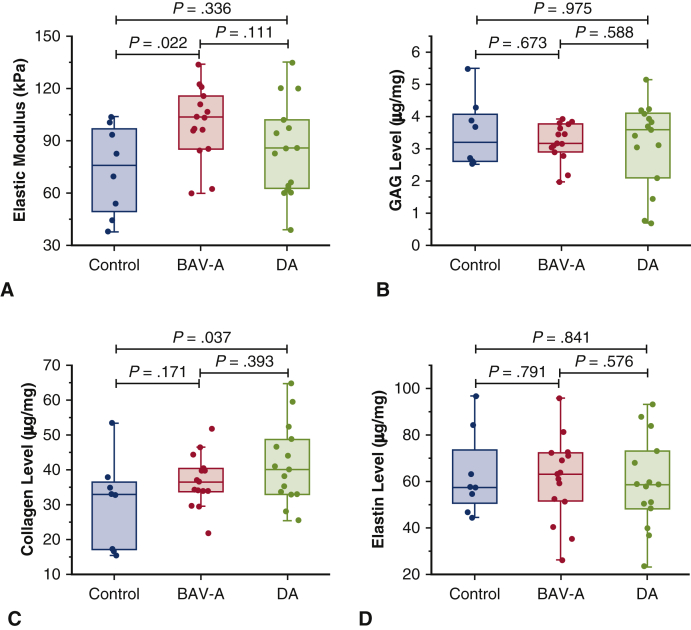
Micromechanical and biochemical data for control (n = 8), BAV-A (n = 15), and tricuspid aortic valve idiopathic DA (n = 15). All data was represented as box plots and data overlaid with upper and lower borders of the box to represent the upper and lower quartiles, and the middle horizontal line to represent the median. The upper and lower whiskers represent 5th and 95th percentile of the data. Variables acquired from the specimens included A, elastic modulus (E) from oscillatory nanoindentation, and levels of B, GAG; C, collagen; and D, elastin from biochemical assays. BAV-A was significantly more elastic in comparison with the control and DA. However, it was DA that had elevated collagen levels relative to the control. Only E was statistically different between the aneurysmal groups. Therefore, we can note that changes in micromechanical behavior between BAV-A and DA cannot be explained by only the levels of GAG and structural proteins within the tissue. Noticeably, BAV-A was overall more homogeneous than control and DA for majority of the in vitro measurements. BAV-A, Bicuspid aortic valve aneurysm; DA, degenerative aneurysm; GAG, glycosaminoglycan.